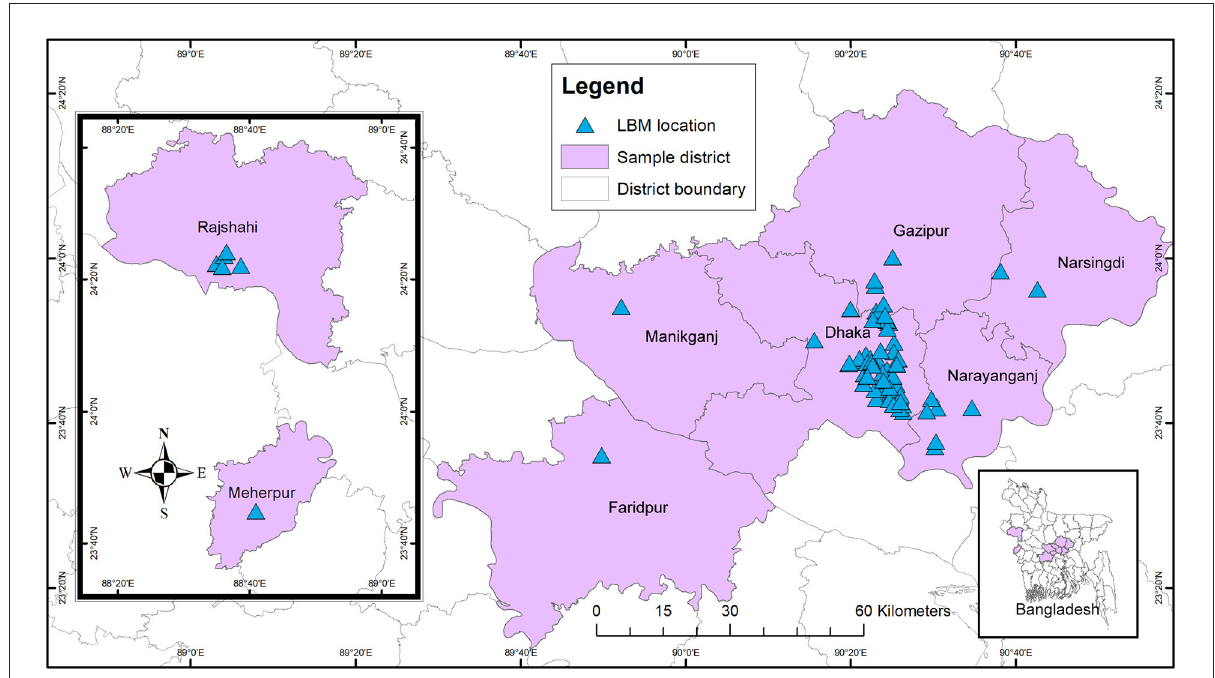
FIGURE1 Sampling locations of LBMs in selective districts in